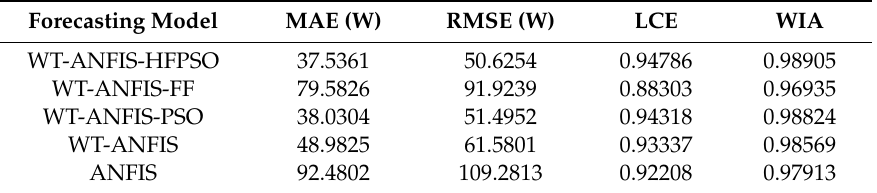
Table 5. Performance comparison of forecasting models on partially cloudy